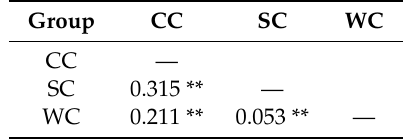
Table 4. The genetic di ff erentiation index F ST values of nad4 population pairwise